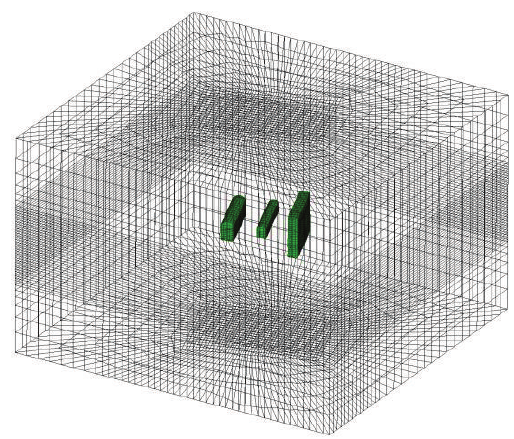
Figure3:3Dfinitedifferentialmodelofundergroundcaverngroups with 𝜃 = 20 ∘ .